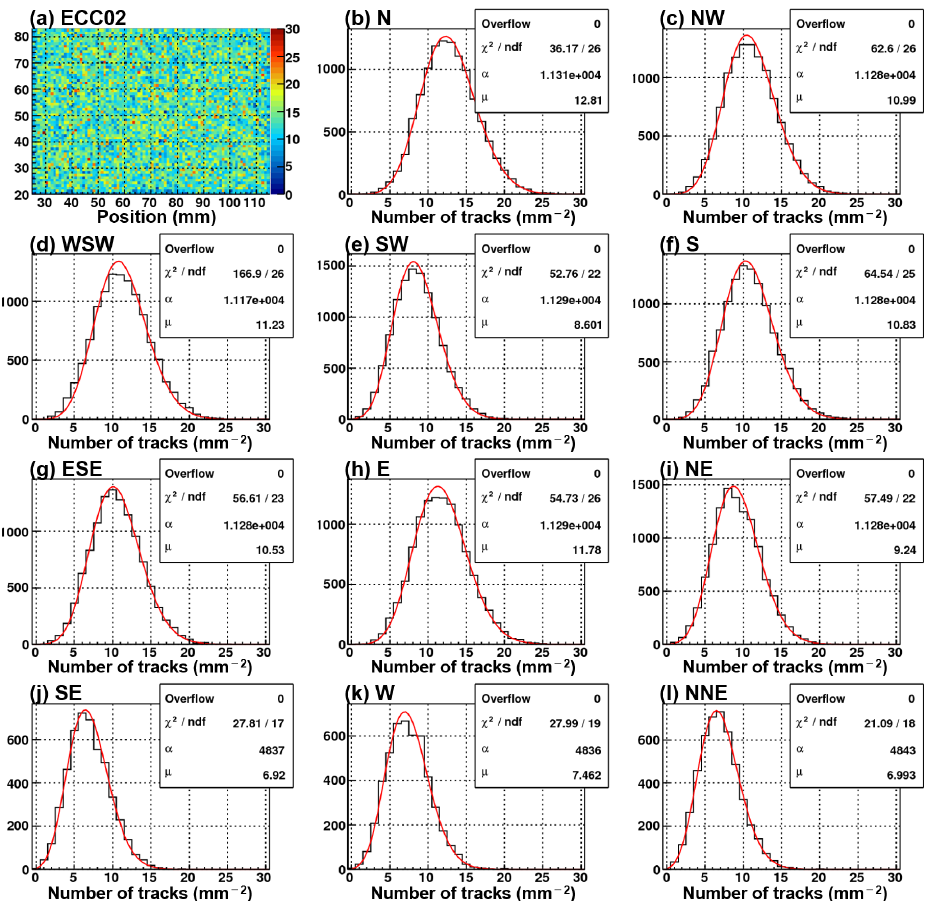
Figure A2. (a) The position distribution of the number of selected tracks per mm 2 in the ECC02. (b–l) The number of selected tracks per mm 2 (the black line) with the fitting result of a Poisson distribution ( = αµ x e − µ /x , the red line) in each observation site, respectively. The tracks selected for this figure came from in the backward direction and have small slopes ( | tan θ x | < 0 . 5 and | tan θ y | < 0 .